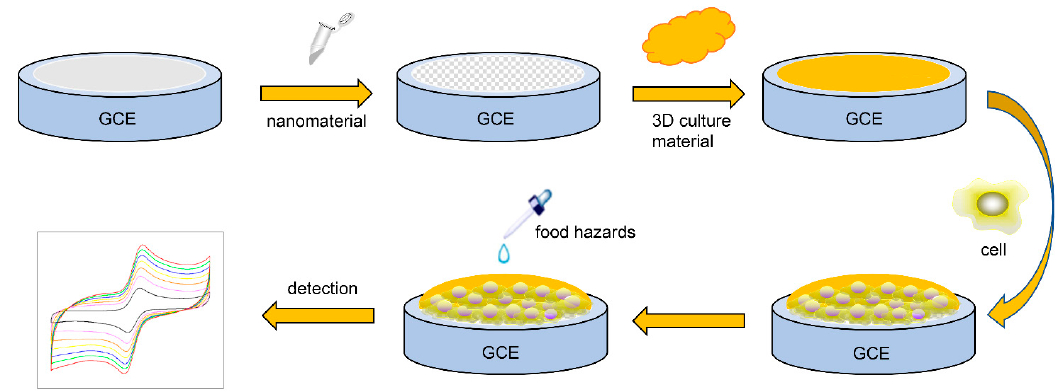
Figure 1. Basic principle of cell-based electrochemical sensors.